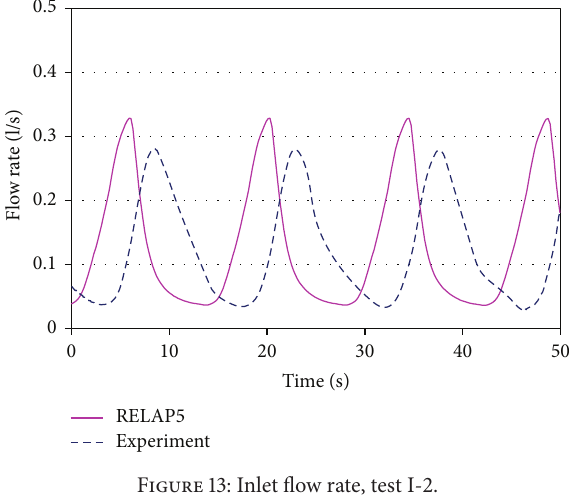
Figure 10: Inlet riser water temperature, test I-1.